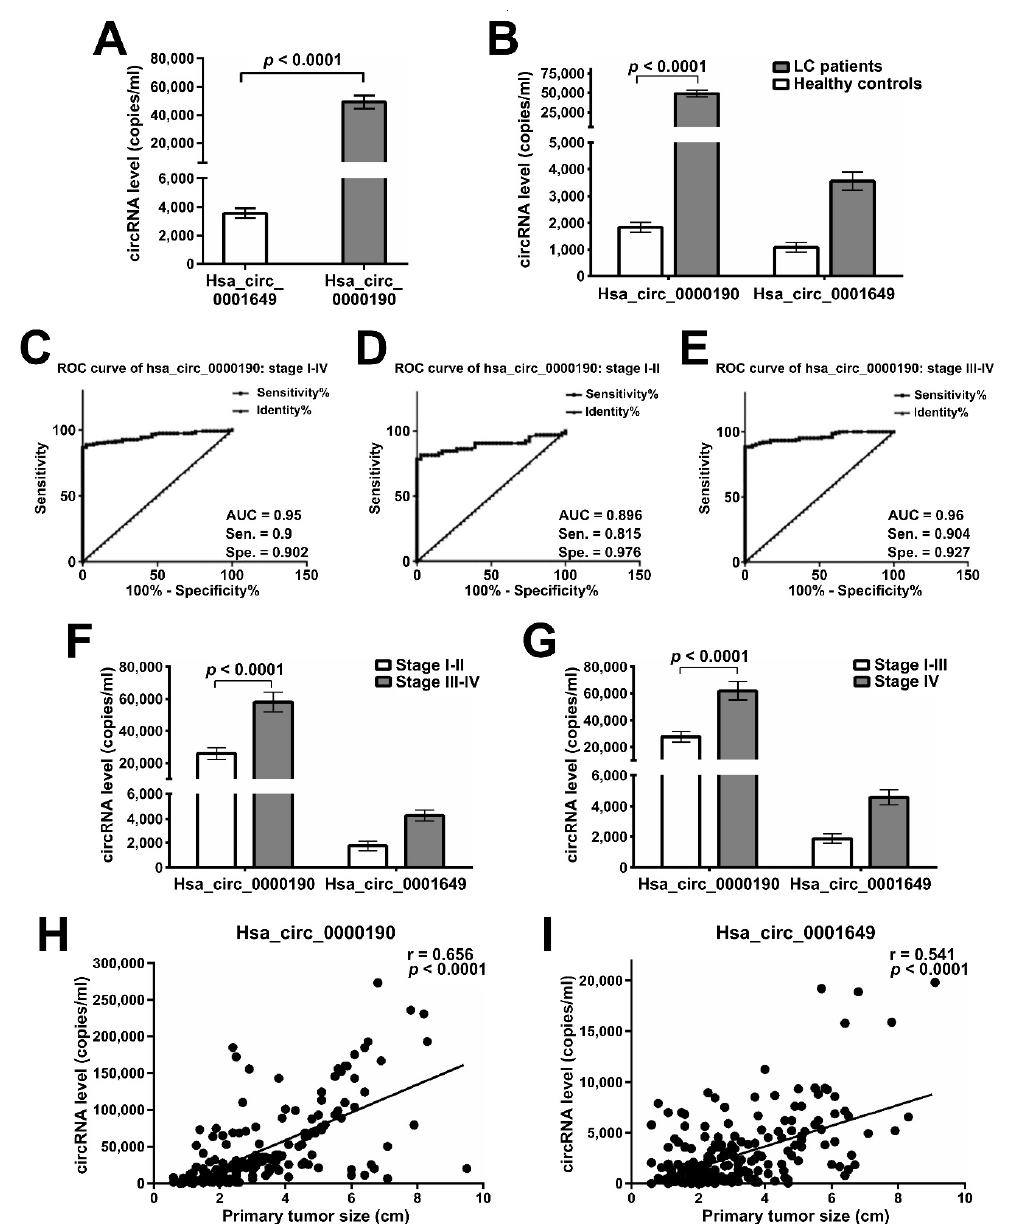
Figure 4. Expression levels of plasma circRNAs in different stages and tumor sizes of LC. ( A ) RT-ddPCR analysis of expression of hsa_circ_0000190 and hsa_circ_0001649 in the plasma of lung cancer patients’ blood samples. Mean values are shown with standard deviation error bars, p -value calculated by Student’s t -test. ( B ) RT-ddPCR analysis of expression of hsa_circ_0000190 and hsa_circ_0001649 in the plasma of lung cancer patients’ and healthy controls’ blood samples. Mean values are shown with standard deviation error bars, p -value calculated by Student’s t -test. ( C – E ) ROC curve analysis of diagnostic ability of hsa_circ_0000190 to discriminate between healthy individuals and LC patients of all TNM stages ( C ), stages I-II ( D ), stages III-IV ( E ). 2722 copies/mL was used as a cut-off value for hsa_circ_0000190 expression threshold. AUC—area under the curve, Sen.—sensitivity, Spe.—specificity. ( F , G ) RT-ddPCR analysis comparing the expression of hsa_circ_0000190 and hsa_circ_0001649 in the plasma of lung cancer patients of stages I-II and stages III-IV ( F ), stages I-III and stage IV ( G ). Mean values are shown with standard deviation error bars, p -value calculated by Student’s t -test. ( H , I ) Pearson correlation analysis of expression levels of hsa_circ_0000190 ( H ) and hsa_circ_0001649 ( I ) and primary tumor